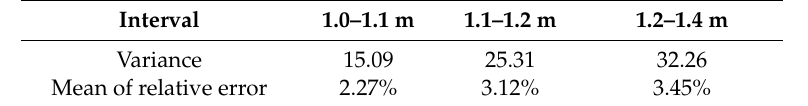
Table 2. Variance and mean of the relative error of different intervals.